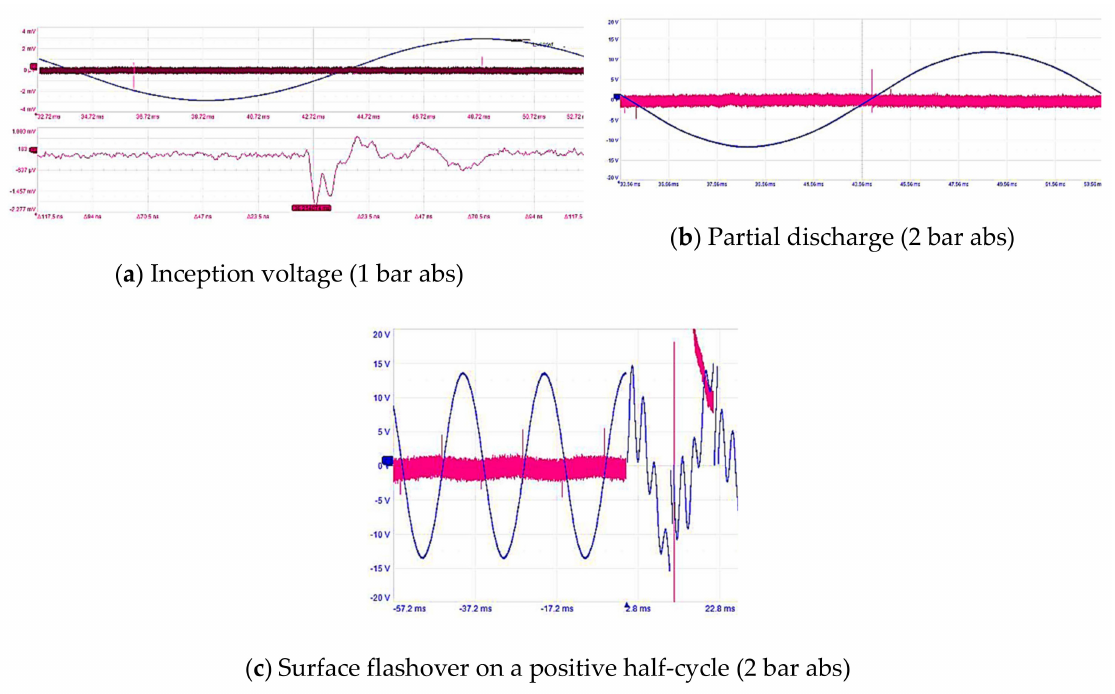
Figure 13. Voltage-current waveform for measuring inception voltage, partial discharge and